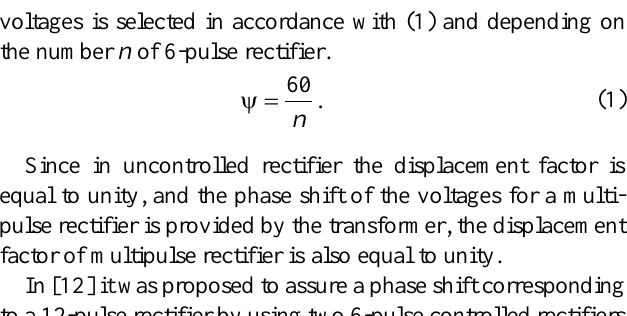
Fig. 3. Voltage waveforms in 12-pulse rectifiers circuit: a) GTO rectifier, b) SCR rectifier.